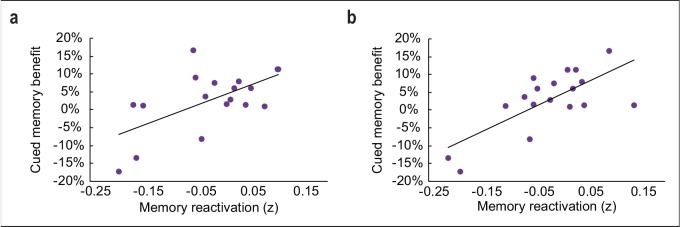
Relationship between odor-evoked memory reactivation and cued memory benefit, restricted to cued categories only.(a-b) When limiting the analysis of memory reactivation to a comparison of the two cued object categories (without including the two non-cued object category templates from initial learning for comparison), reactivation measures remained significantly correlated with behavioral memory enhancement in a cluster of interest in vmPFC (a; r(16) = 0.61, p = 0.01) and posterior fusiform cortex (b; r(16) = 0.72, p < 0.001).10.7554/eLife.39681.024Figure 4—source data 1.Relates to panel (a).10.7554/eLife.39681.025Figure 4—source data 2.Relates to panel (b).